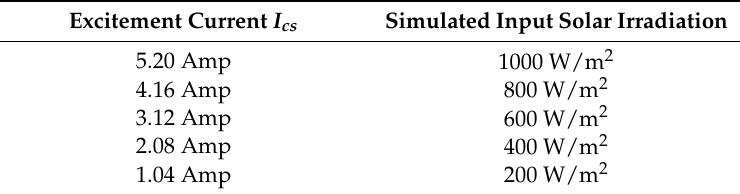
Table 2. Correlation between the excitement current and the simulated input irradiance on the PV panel STP175S-24/Ac at 25 °C.